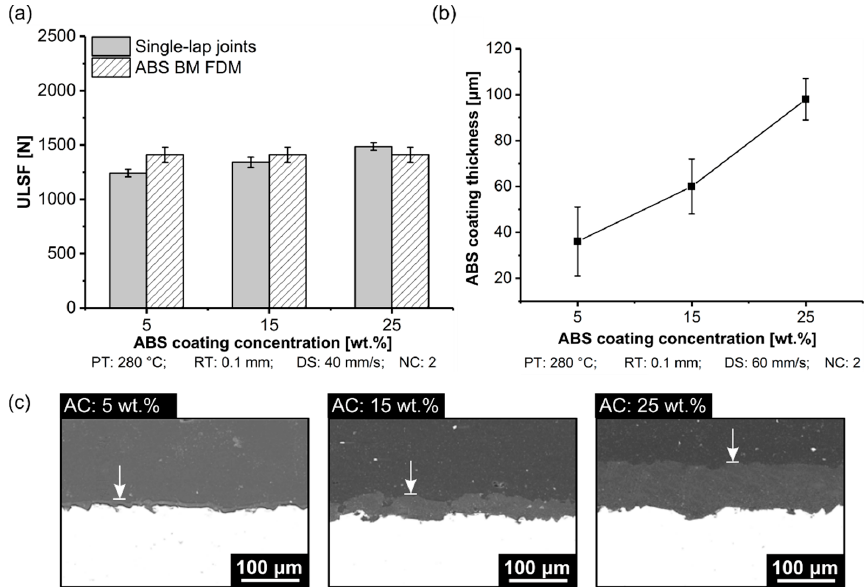
Figure 19. Influence of the ABS coating concentration on the aluminum 2024 ‐ T3/ABS hybrid ( a ) ULSF, ( b ) ABS coating thickness, and ( c ) detailed view from the ABS film formation (condition eight, AC: 5 wt.%; condition seven, AC: 15 wt.%; condition nine, AC: 25 wt.%; the following parameters PT: 280 °C, RT: 0.1 mm, DS: 60 mm/s, and NC: 2 were fixed for the conditions investigated).